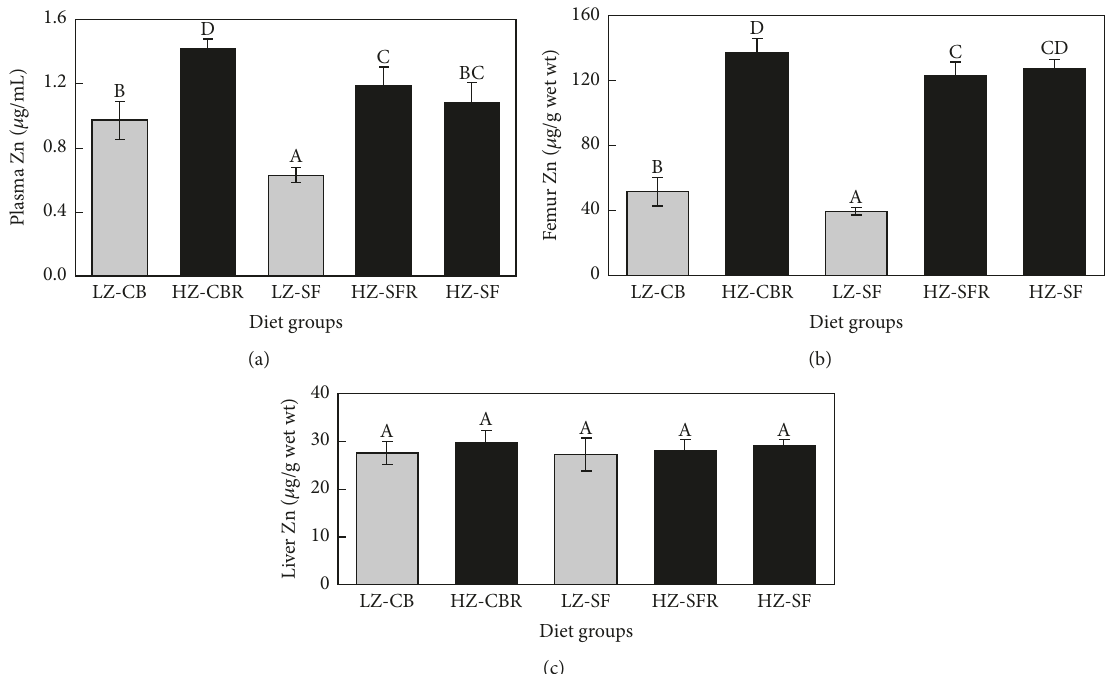
Figure 2: Plasma, femur, and liver Zn concentrations of male weanling rats fed high-fat diets differing in Zn content and fat source for 4 wk. Columns represent means ± SDs, 𝑛 = 8 . Labeled means without a common letter differ, 𝑃 < 0.05 (1-factor ANOVA followed by Tukey’s multiple-comparisontest).BifactorialANOVAoftheLZ-CB,HZ-CBR,LZ-SF,andHZ-SFR:significance( P )ofZn,fat,andzinc × fatis < 0.001, < 0.001, and 0.098 for plasma Zn, < 0.001, 0.006, and 0.82 for femur Zn, and 0.13, 0.32, and 0.54 for liver Zn concentrations, respectively. Diet groups: LZ-CB, low-Zn (LZ) cocoa butter (CB) diet fed free choice; HZ-CBR, high-Zn (HZ) CB diet fed in restricted amounts equivalent to intake of the LZ-CB diet; LZ-SF, LZ safflower oil (SF) diet fed free choice; HZ-SFR, HZ-SF diet fed in restricted amounts equivalent to intake of the LZ-SF diet; HZ-SF, HZ-SF diet fed free